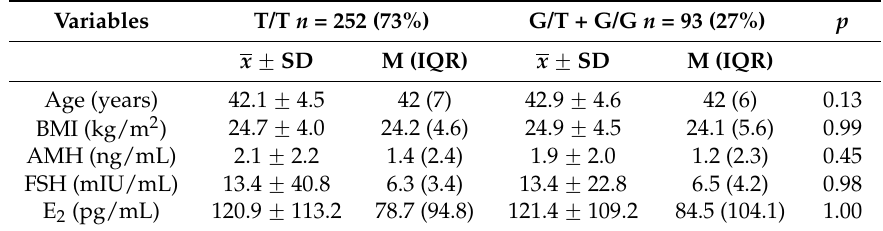
Table 3. The genotypes of the AMH Ile 49 Ser polymorphism (rs10407022) vs. age, BMI, hormone levels and ovarian parameters in the follicular phase in healthy late reproductive stage women ( n = 345). Variables